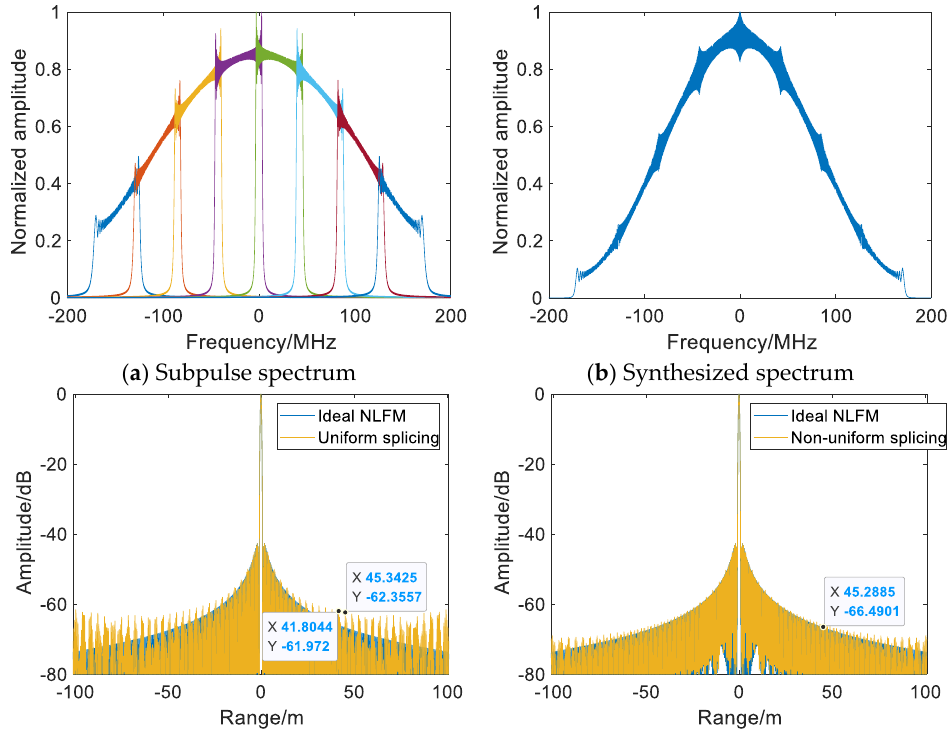
Figure 4. Range-compressed NLFM SWW ( N = 8 B = 50 MHz ∆ f = 42.5 MHz T syn = 145 µ s).